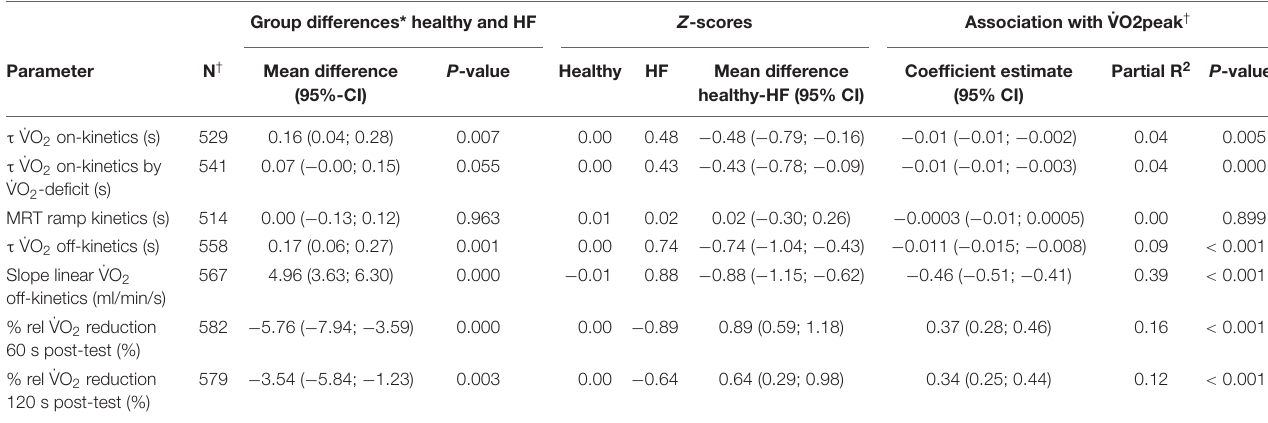
TABLE 2 | Group differences between healthy participants and patients with heart failure, Z -scores and the association with ˙VO 2peak for all kinetic parameters. Group differences* healthy and HF Z -scores Association with ˙VO2peak †